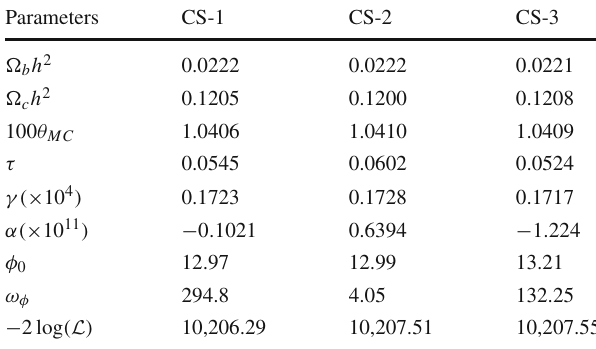
Table4 Best-fitparametersandlikelihoodsobtainedforthecandidates of the CamSpec cleanTTTEEE+ lowT + lowE likelihood. First four are the (cid:2) CDMbackgroundparametersandthenextfouraretheinflationary potential parameters. Final row gives the χ 2 values obtained by the candidates. Improvement in fit obtained are 5, 3.8, and 3.7 respectively for the candidates CS-1, CS-2 and CS-3 Parameters